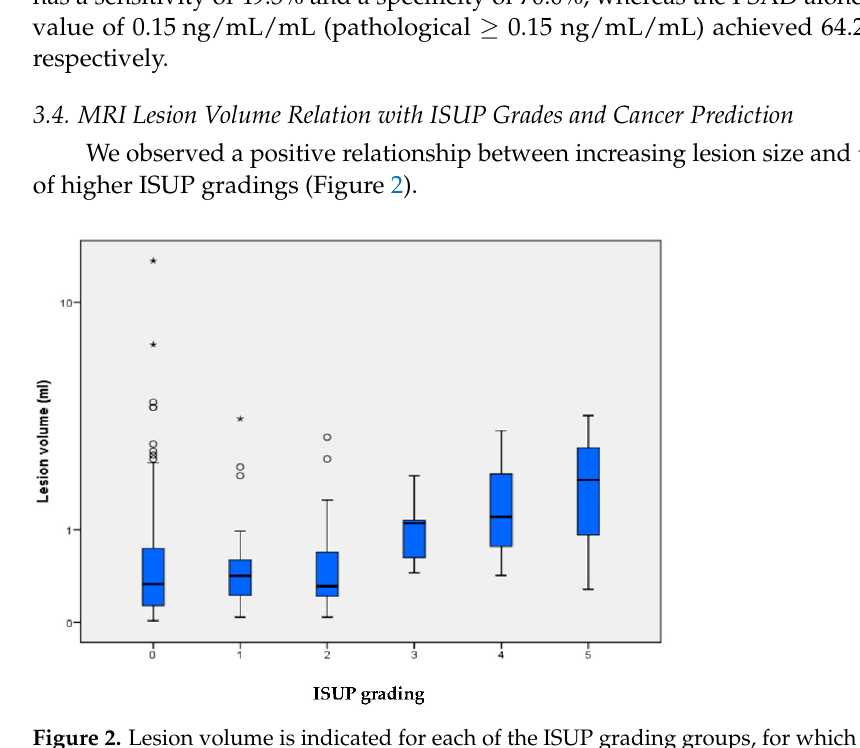
Table 3. Sensitivity and specificity for clinically significant prostate cancer (ISUP ≥ 2); mpMRI was